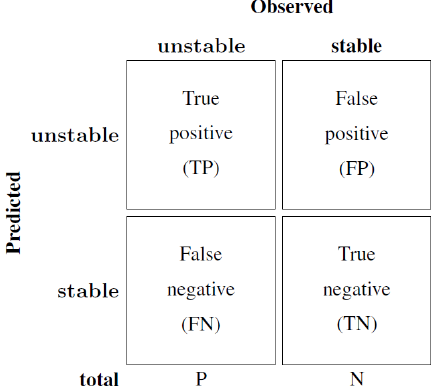
Figure 5. Contingency